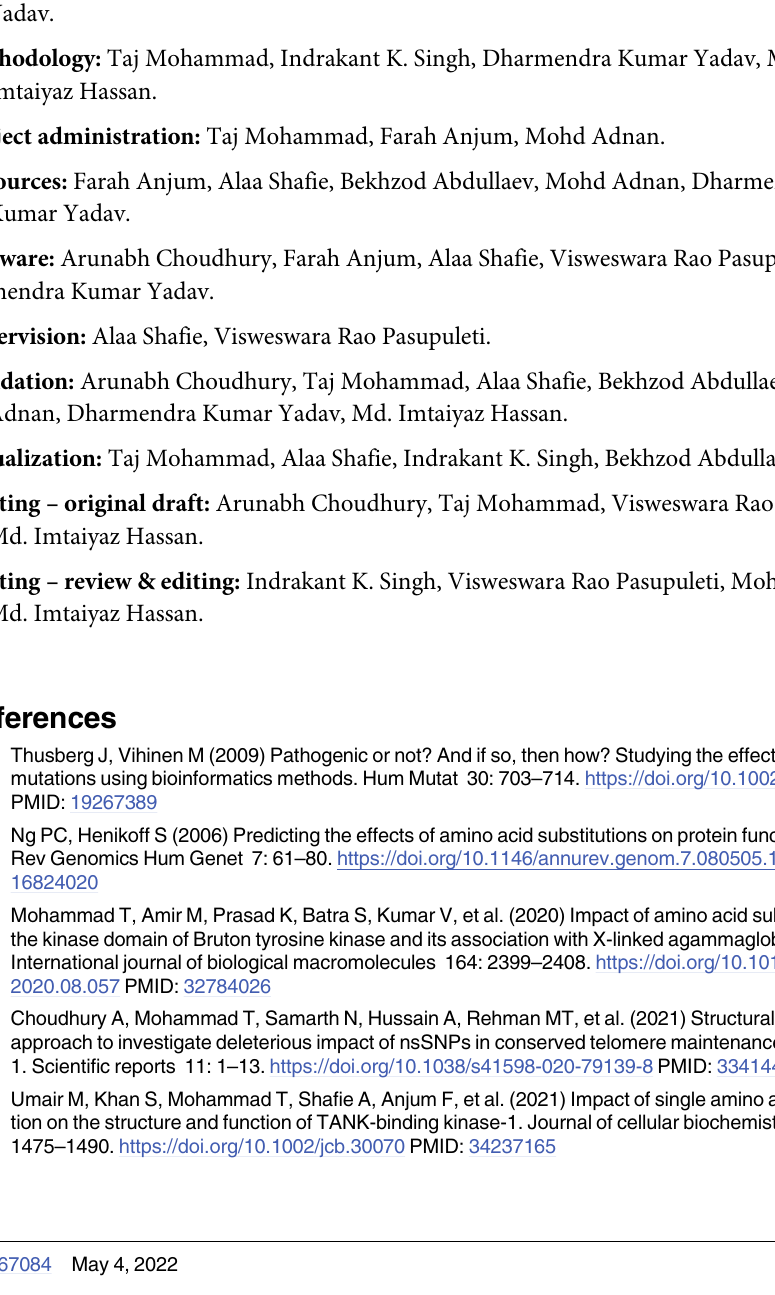
S5 Fig. Distribution of deleterious/destabilizing mutations predicted by all 15 tools for